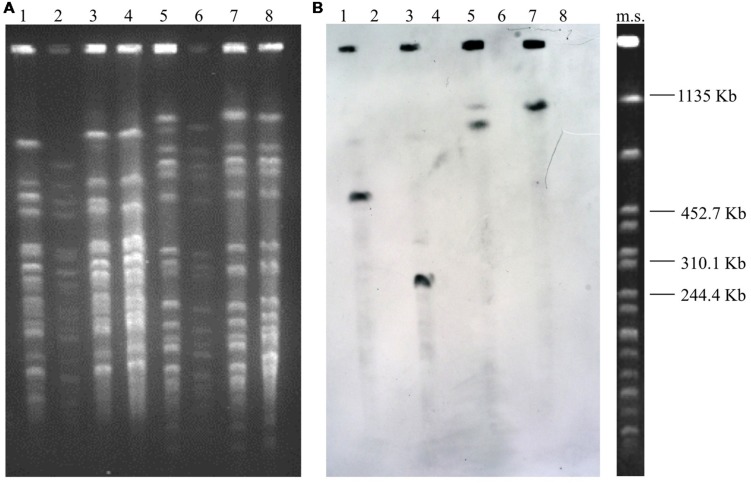
Pulsed-field gel electrophoresis patterns of the genomic DNA of the WT C. butyricum type E strains and their Δmp derivative strains restricted with XhoI (lanes 1–4) and SmaI (lanes 5–8) (A), and Southern hybridization analysis using the latt gene probe (B). Strains ISS-21 (lanes 1 and 5); ISS-21Δmp590 (lanes 2 and 6); ISS-190 (lanes 3 and 7); ISS-190Δmp758 (lanes 4 and 8). Ms, molecular standard, XbaI-digested DNA from Salmonella Braenderup strain H9812 (Hunter et al., 2005).